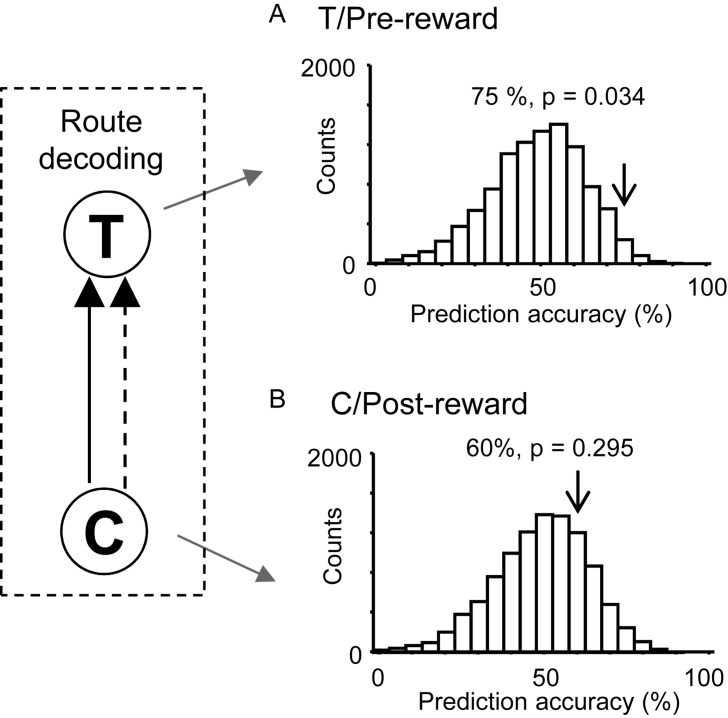
Bayesian decoding of overlapping path segments from reward-related activity in the control VN task. (A) Route decoding from pre-reward activity before reward delivery at the T-reward area. (B) Route decoding from post-reward activity after reward delivery at the C-reward area. The arrow in each histogram indicates the actual prediction accuracy, while the histogram indicates the chance level distribution obtained using the “bootstrap” procedure (10,000 repetitions). The p-value for each prediction accuracy was calculated as the ratio of the count of the values ≥ the actual prediction accuracy in the chance.